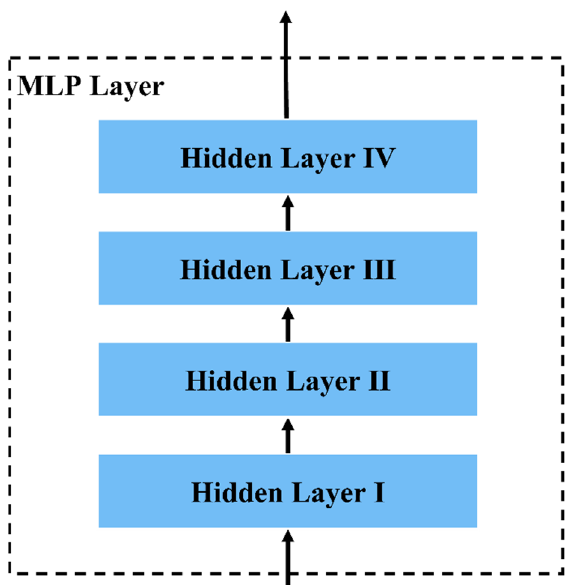
Figure 6. The structure of the MLP layer. The final output of the MLP layer is eight classifications.